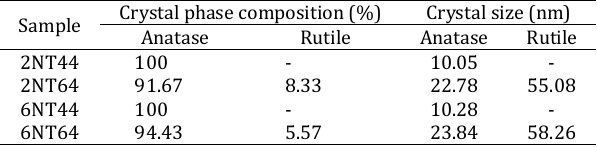
Table 1. Crystal size and phase composition for different N-doped TiO2 Table 1: Crystal size and phase composition for different N-doped TiO 2 sample